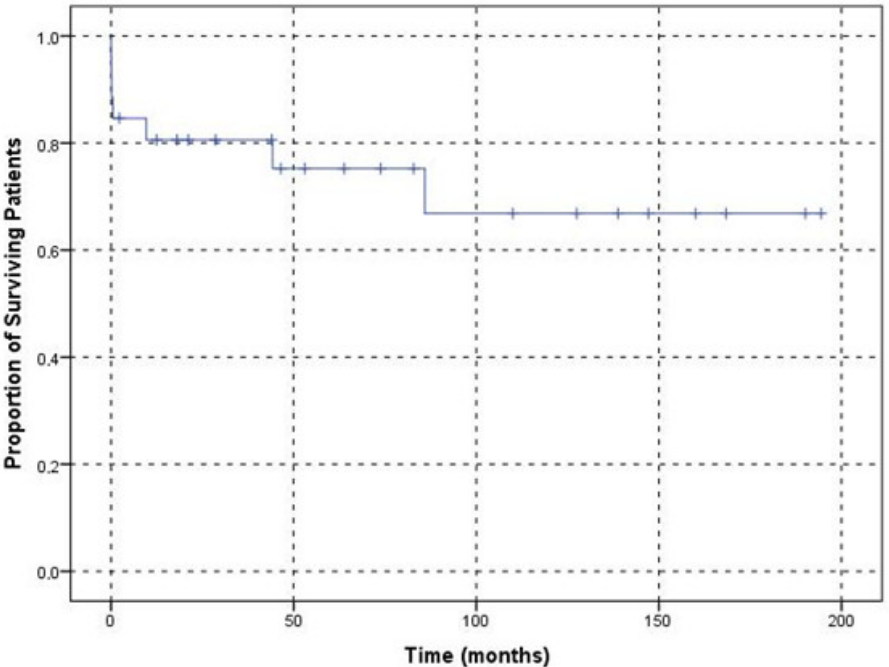
Figure 4. Kaplan–Meier plot showing the overall survival of patients with acquired haemophilia A.